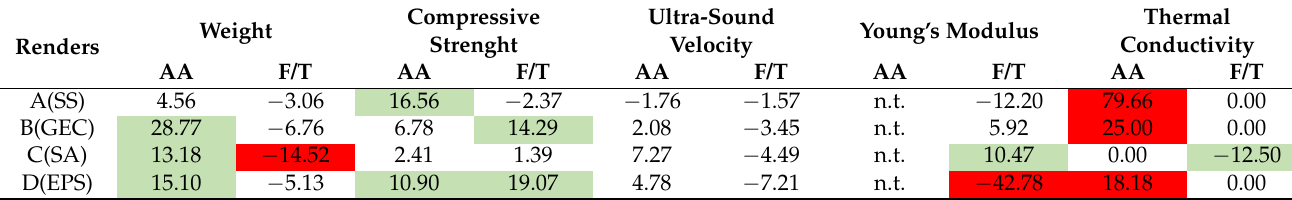
Table 5. Variation in % after accelerated aging